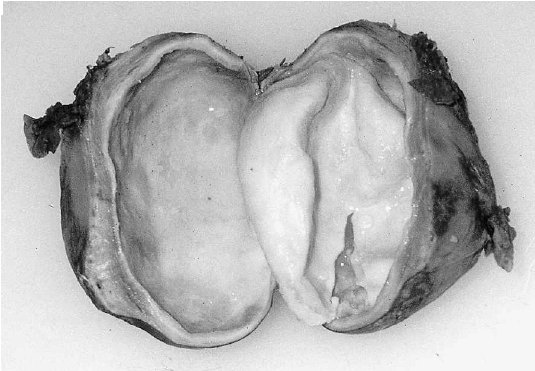
white cyst with surrounding fibrous